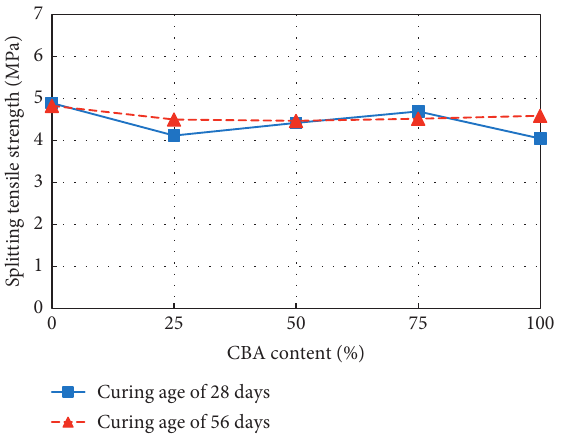
Figure 7: Splitting tensile strength test results.